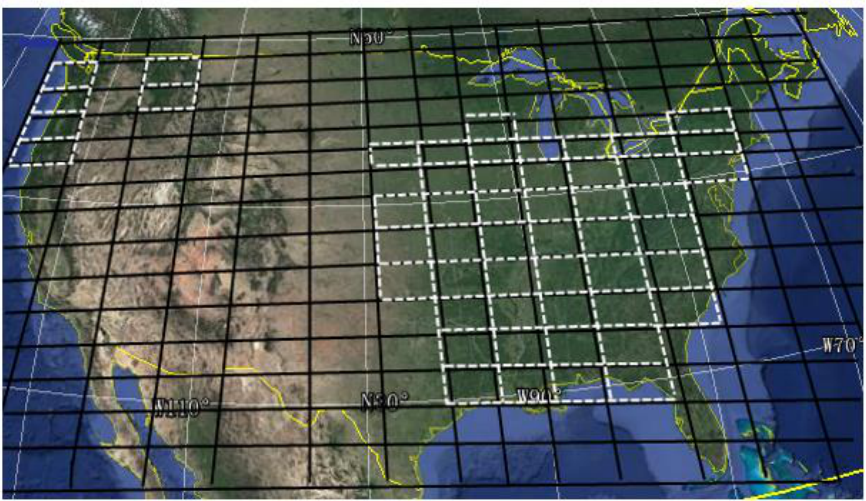
Figure 1. Grid division of tornadoes in the United States from 1967 to 2016.